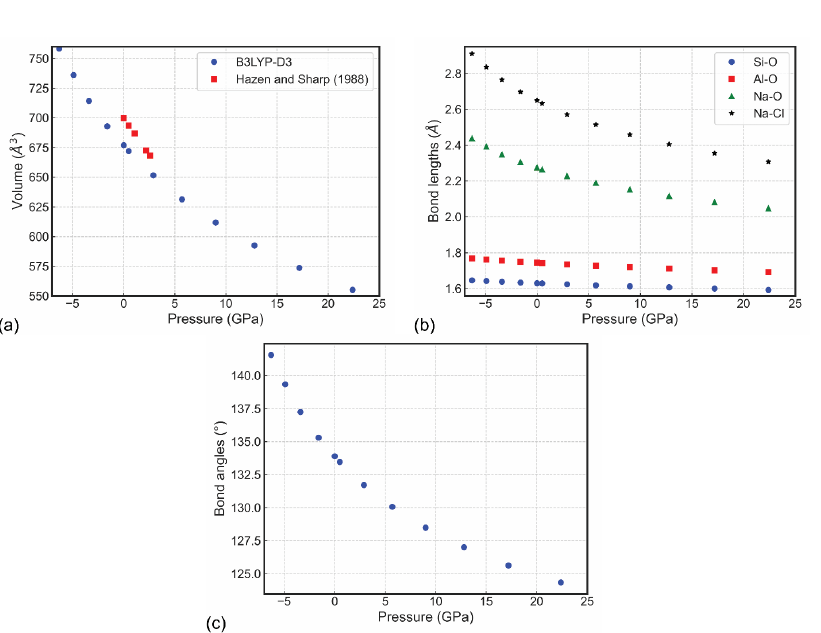
Figure 2. Sodalite ( a ) unit cell volume, ( b ) bond lengths and ( c ) Si–O–Al bridging angle variations as a function of pressure. In panel ( a ), the results of Hazen and Sharp [14] are reported for a direct comparison.